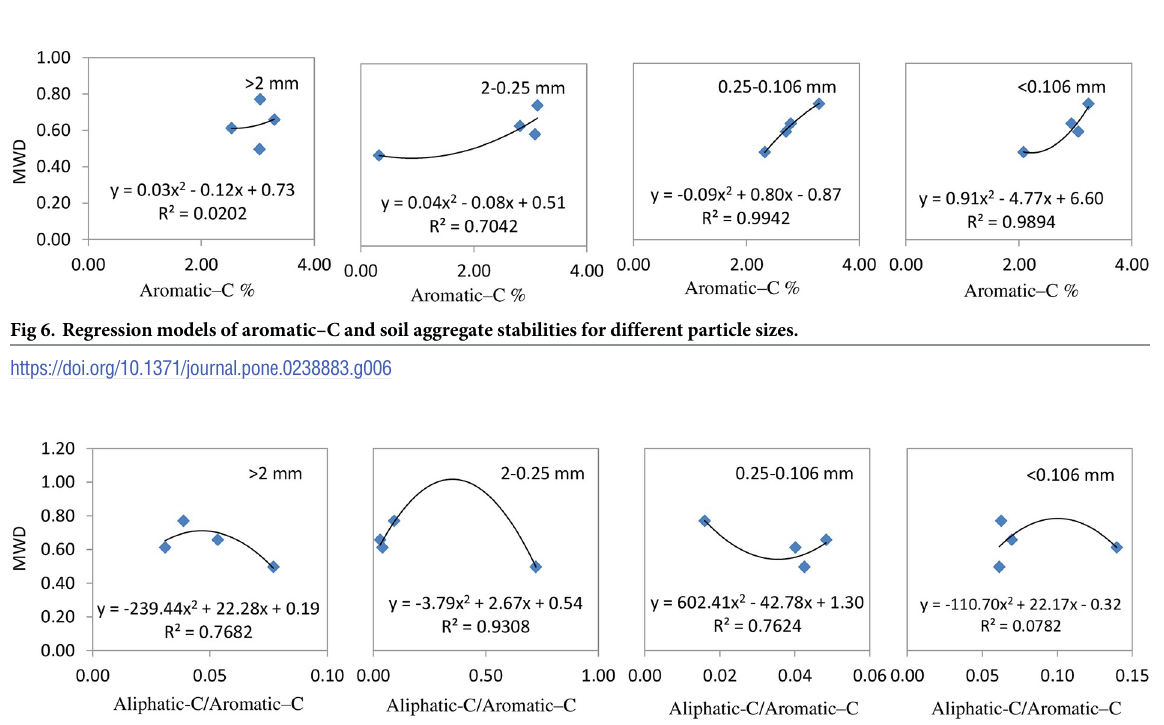
Fig 7. Regression models of aliphatic–C/aromatic–C content and soil aggregate stabilities for different particle sizes.